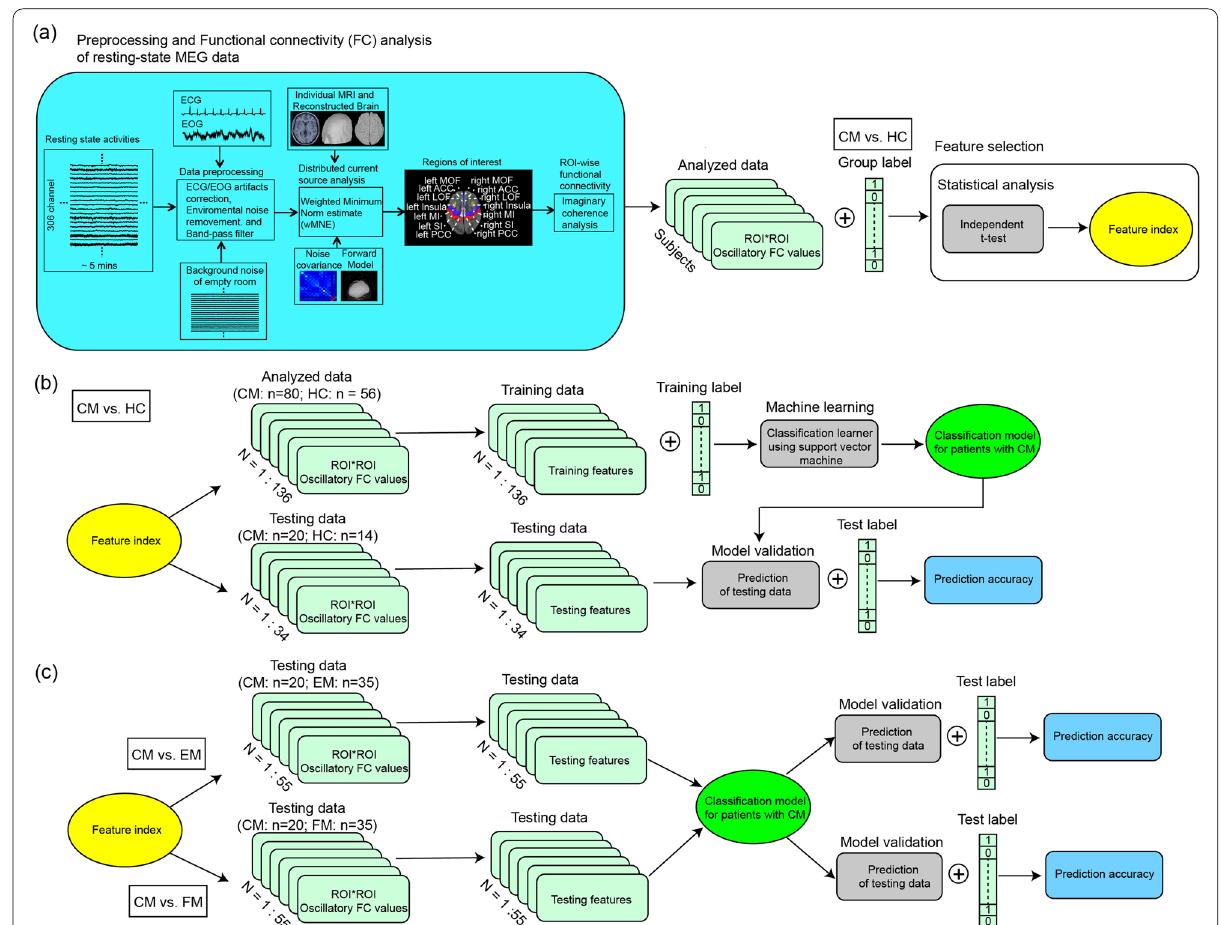
Fig. 1 Pipeline of the resting‑state MEG and machine learning analysis. CM, chronic migraine; HC, healthy controls; EM, episodic migraine; FM, fibromyalgia